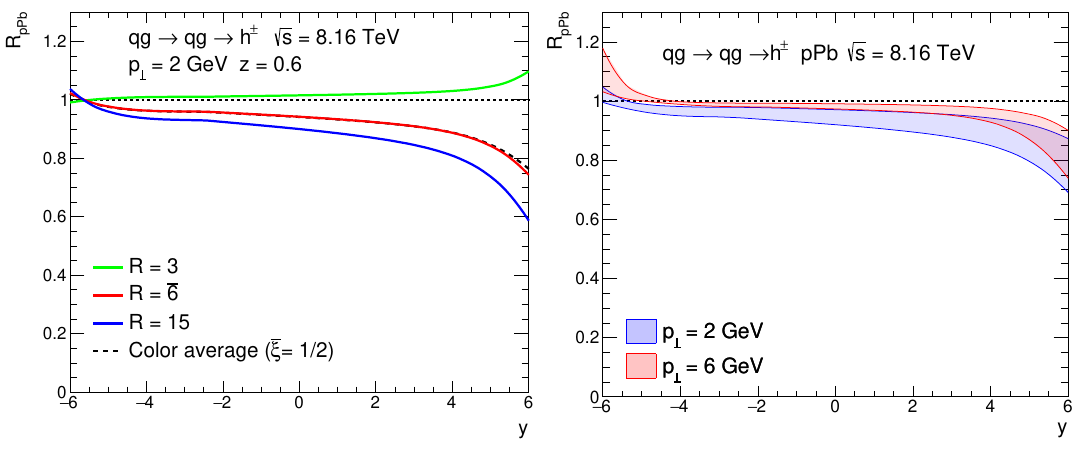
Figure 6 . Left: rapidity dependence of R R (green line), R = (cid:22)6 (red line), R = 15 (blue line). The color-averaged nuclear production ratio, R h , is shown for (cid:22) (cid:24) = 1 = 2 (dashed black line). Right: rapidity dependence of R h pA (blue band) and p = 6 GeV (red band) in the qg ?